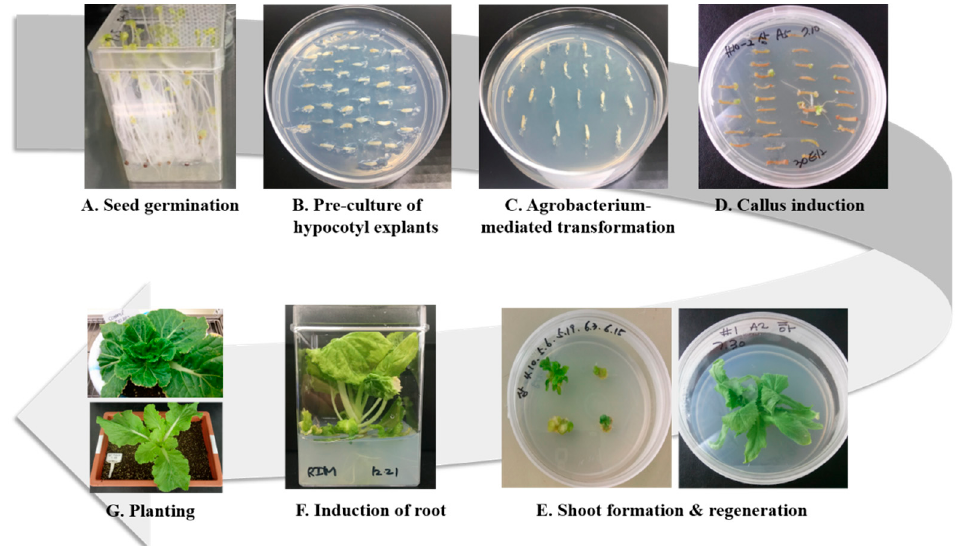
Figure 2. Agrobacterium -mediated Chinese cabbage transformation and generation of transgenic Chinese cabbage carrying transgenes encoding EpCAM–IgM Fc and J-chain K. ( A ) In Vitro seed germination to generate Chinese cabbage seedlings. ( B ) In Vitro preculture of hypocotyls in media. ( C ) Agrobacterium -inoculated hypocotyls incubated in in vitro regeneration media. ( D ) Callus generated from in vitro callus-inducing media. ( E ) Shoot regeneration from calli under the regeneration media. The left shows newly regenerated shoots from the callus. The right shows shoots after further growth following transfer to new regeneration media. ( F ) Root induction from the regenerants in root-inducing media. ( G ) In Vivo T 0 transgenic Chinese cabbage growth after transplanting into pots with soil from the in vitro root-induced transgenic plants.